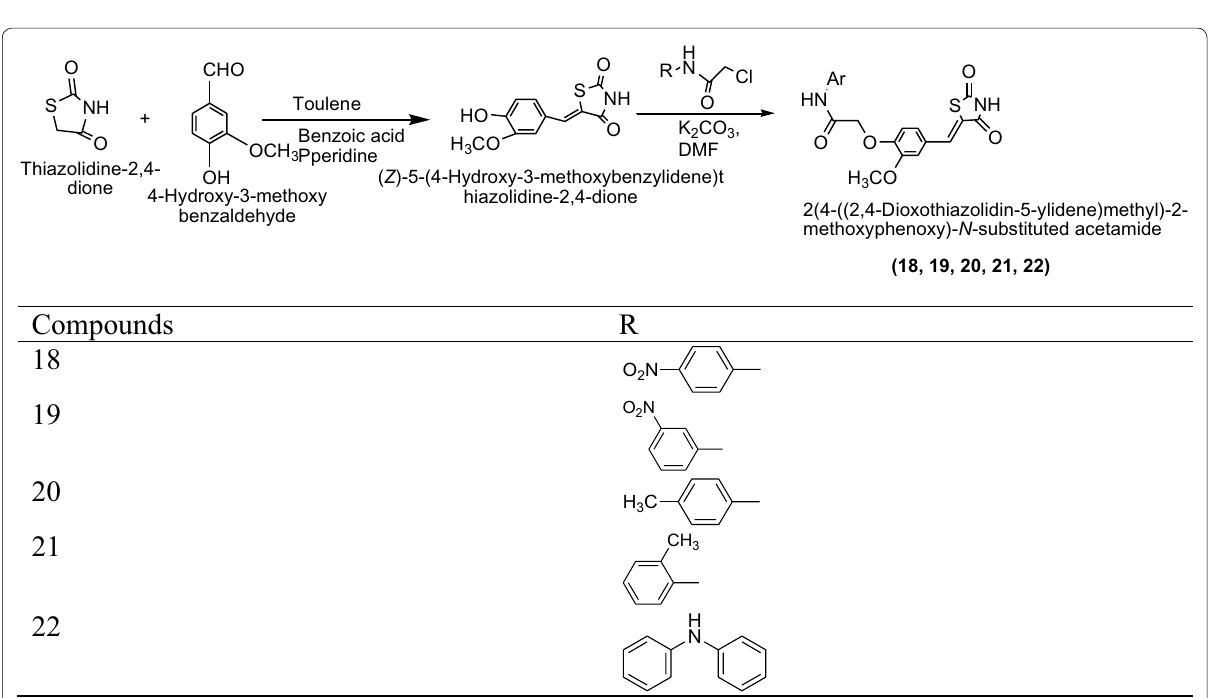
Table 8 Evaluation of hypoglycemic activity: effect of compound on % decrease in blood glucose in diabetic mice Compounds